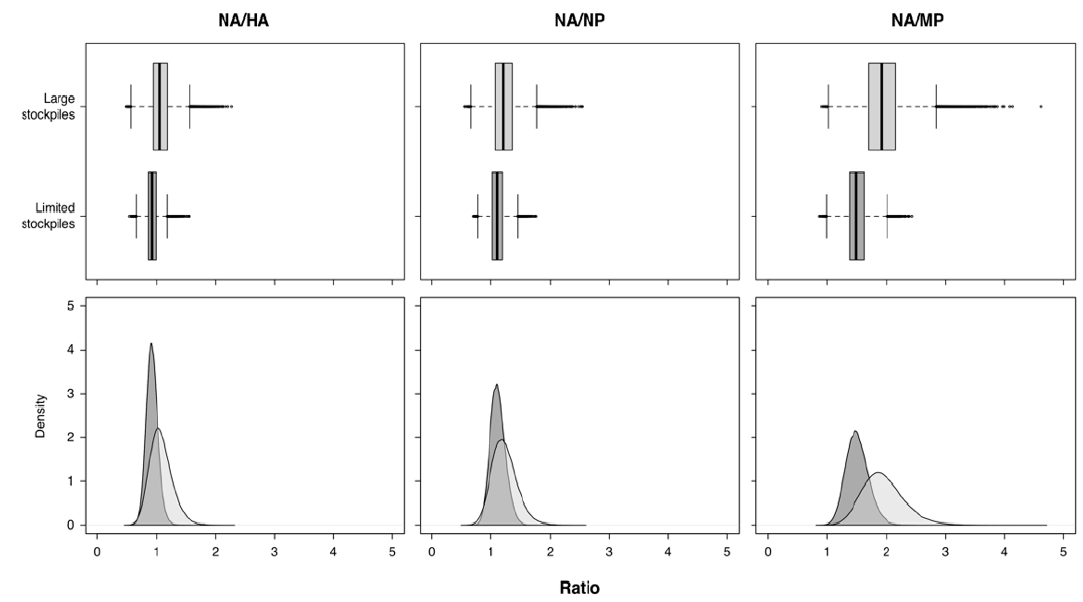
Figure 1. Distribution of the evolutionary rates ratios between NA and the reference genes (HA, NP, and MP from left to right ). Data from countries with large antiviral stockpiles are represented in light gray, whereas those from countries with limited antiviral stockpiles are represented in dark gray.